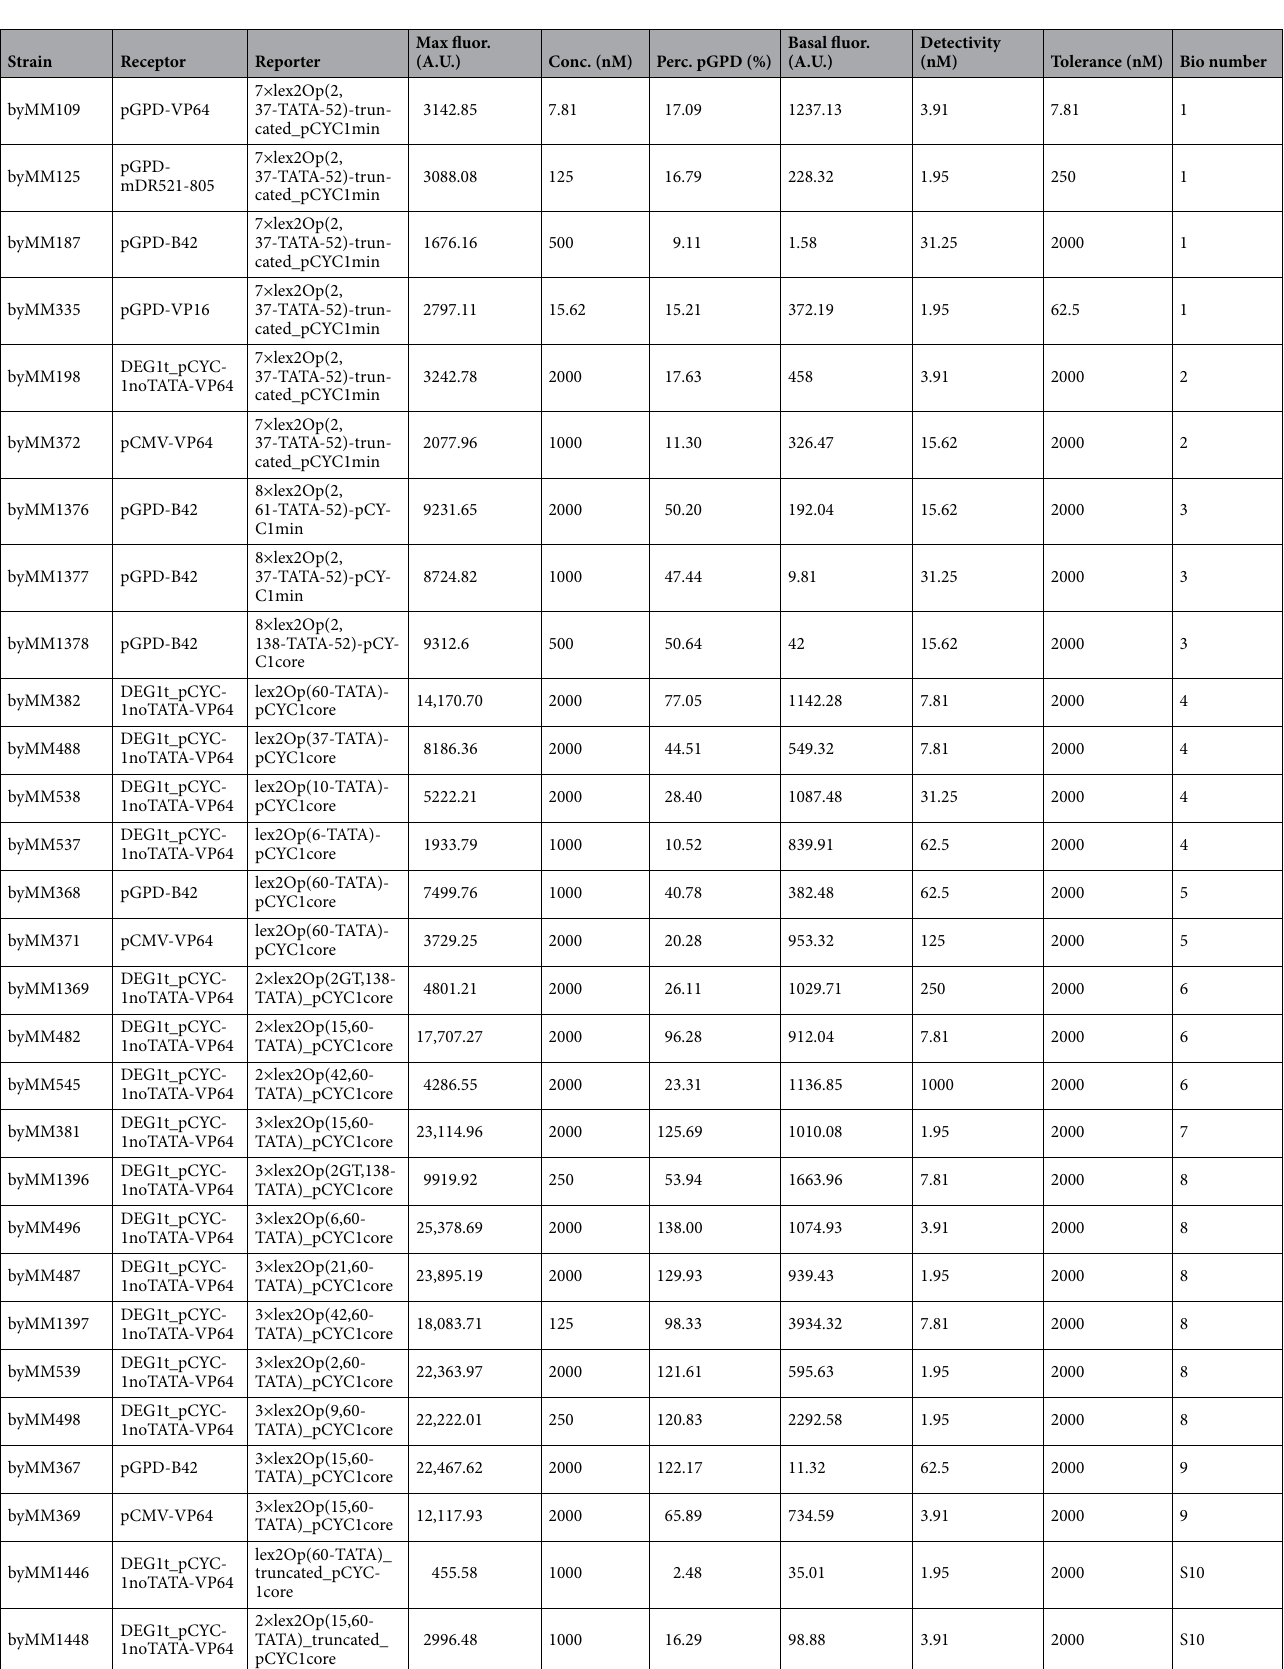
Table 1. Overview of the biosensors’